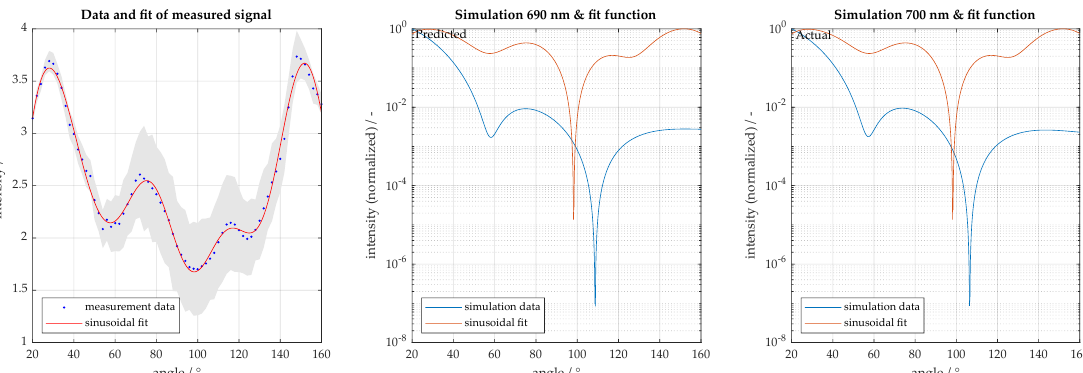
Figure 7. Particle size characterization for 681 nm silica particles (particle size displayed is rounded to 680). Light scatter measured in 2 ◦ increments from 20 ◦ to 160 ◦ . ( a ) Measurement and sinusoidal fit with 95% confidence intervals shown in gray; ( b ) comparison to best fit result; ( c ) comparison to actual particle size.